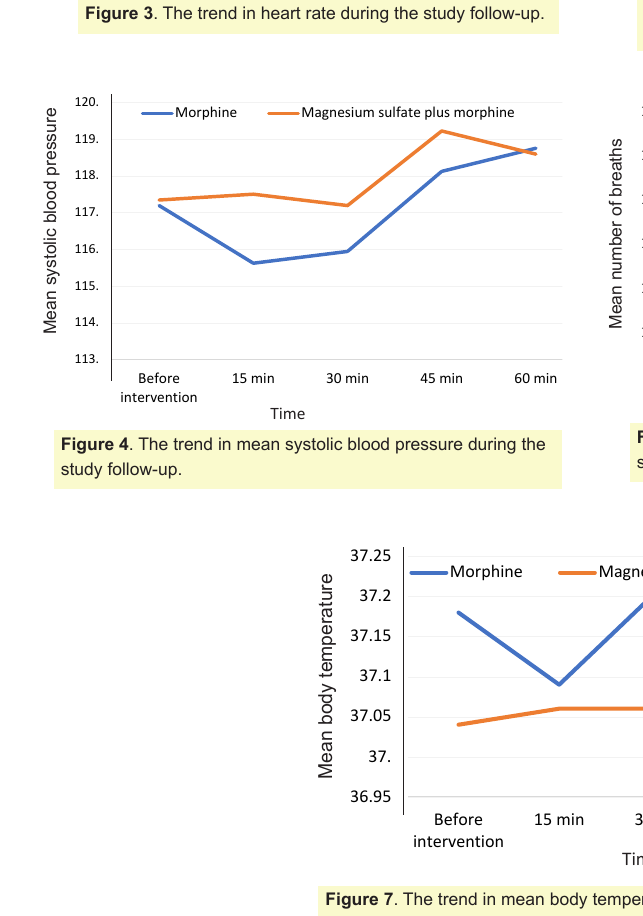
Figure 3 . The trend in heart rate during the study follow-up.